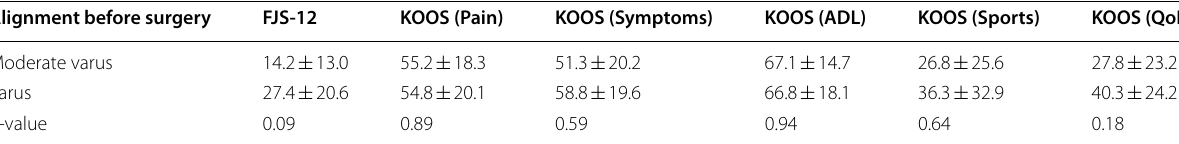
Table 2 Comparison of preoperative value for each patient-reported outcome measure between the moderate varus alignment group and the varus alignment group